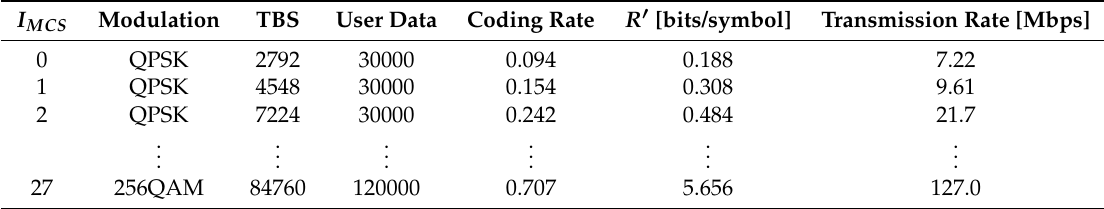
Table 5. Relationship between MCS index and transmission rate under frequency division duplex (FDD)-LTE (100 RBs, 20